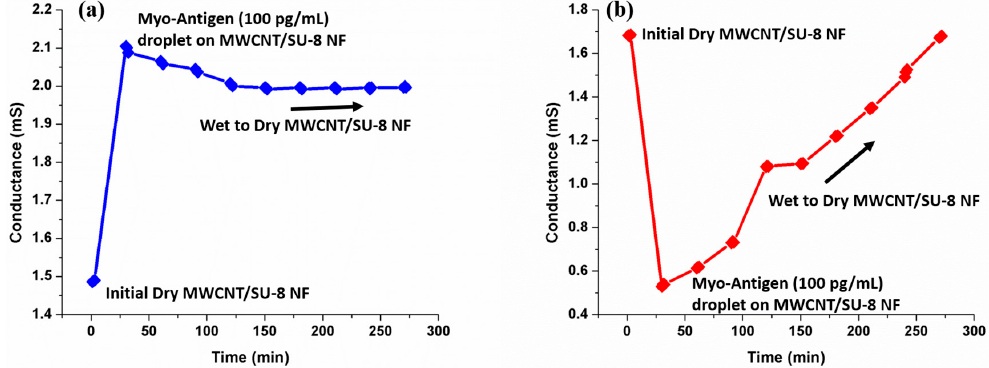
Figure 9. Variation of conductance with respect to time for a concentration of 100 pg/mL myglobin on ( a ) Functionalized nanofiber ( b ) Non-functionalized Nanofiber.